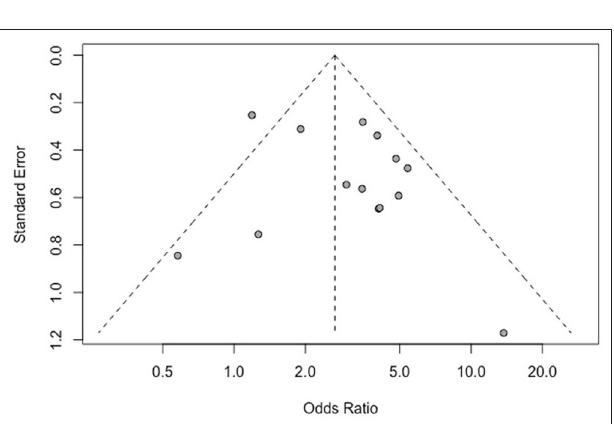
FIGURE 6 | Funnel plot of the correlation between IDH mutation and perioperative epilepsy. IDH, isocitrate